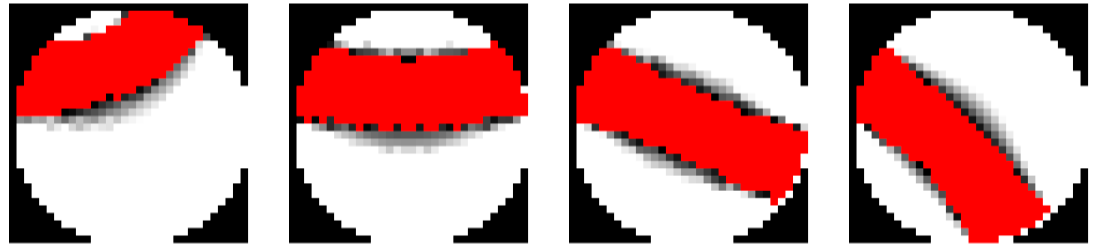
Figure 4. Visualization of sensitivity matrix parts, an example. The red color stands for amplified values between pairs of electrodes.